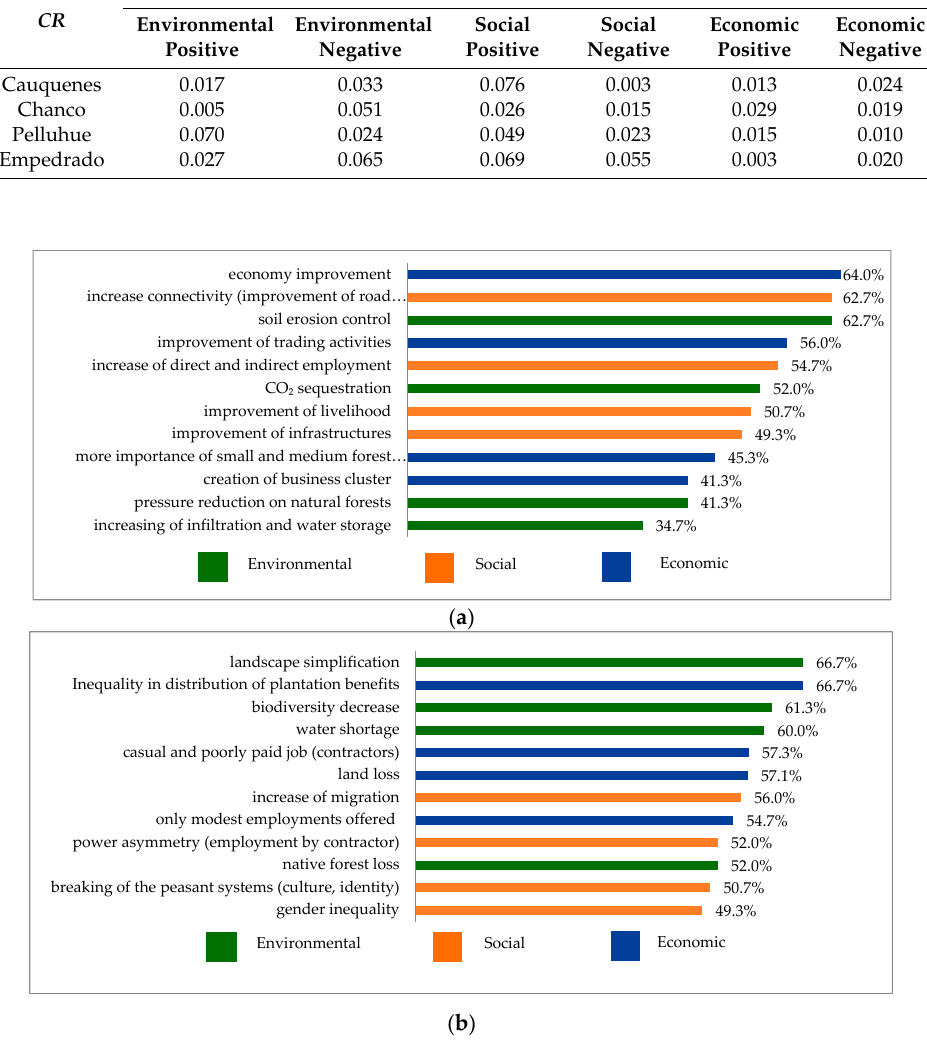
Figure 5. Estimations of Experts Response Indicator ( ERI ) from experts’ consultation ( n = 15). ( a ) positive externalities; ( b ) negative externalities.